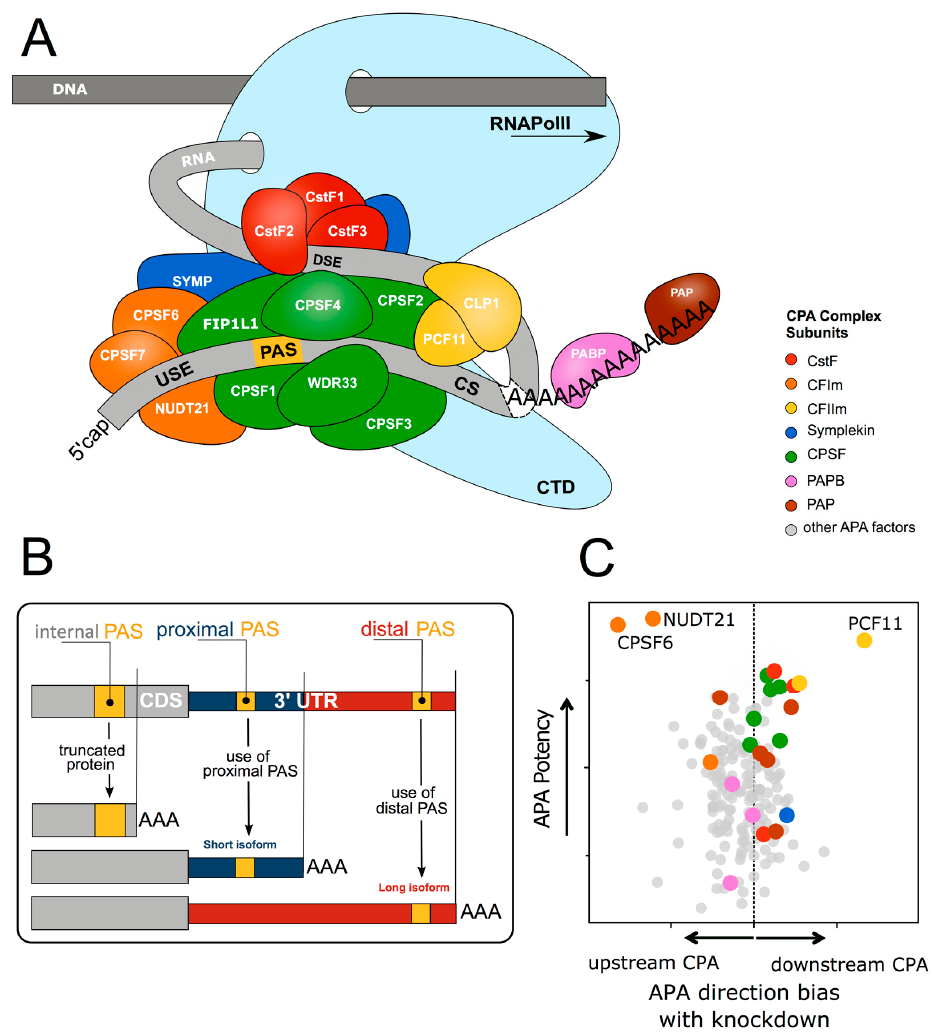
Figure 1. The core 3 ′ end RNA processing machinery and impact on alternative polyadenylation. ( A ) The core 3 ′ end processing machinery consists of complexes composed of multiple trans acting proteins interacting with RNA via multiple cis-elements (USE = upstream sequence element; PAS = poly(A) signal; CS = cleavage site; DSE = downstream sequence element; CTD = C-terminal domain). Upon co-transcriptional assembly of these complexes, RNA cleavage and polyadenylation occurs to form the 3 ′ end of the nascent RNA molecule. ( B ) More than 70% of all genes harbour more than one polyadenylation signal (PAS). This gives rise to transcript isoforms differing at the mRNA 3 ′ end. While alternative polyadenylation (APA) in 3 ′ UTR changes the properties of the mRNA (stability, localisation, translation), internal PAS usage (in introns or the coding sequence (CDS)) changes the C-termini of the encoded protein, resulting in different functional or regulatory properties. ( C ) Abundance of individual 3 ′ end processing components results in variable impacts on level and direction of APA (compare [13]). Shown are effects on global PAS choice after siRNA depletion of more than 170 potential APA regulators, including the highlighted core CPA components (color code corresponds to complexes depicted in Figure 1a; Y-axis shows effect size, X-axis shows directionality of global APA bias upon depletion of individual factors (further information see Supplementary Figure 2 [13])). While depletion of most factors does not show any directional APA bias, depletion of the CFIm (NUDT21 and CPSF6) and CFIIm (PCF11) complex components pervasively regulate APA in a unidirectional manner (i.e., resulting in primarily longer or shorter transcript isoforms after depletion of PCF11 or NUDT21, and CPSF6 respectively) Further data can be found in TREND-DB (http://shiny.imbei.uni-mainz.de:3838/trend-db/).